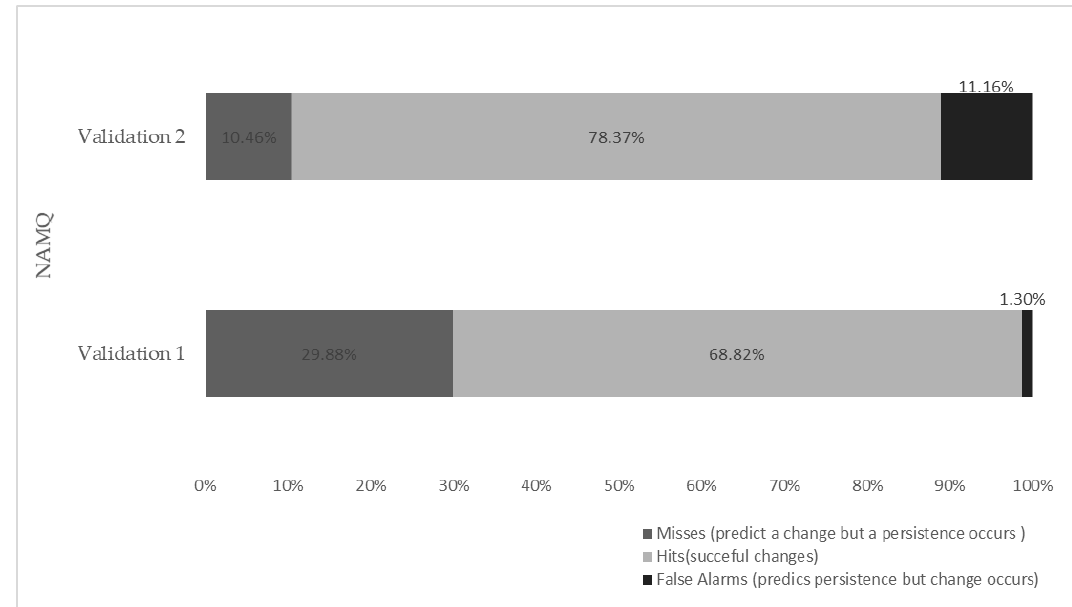
Figure 6. Merit figure between observed and predicted 2017 maps.